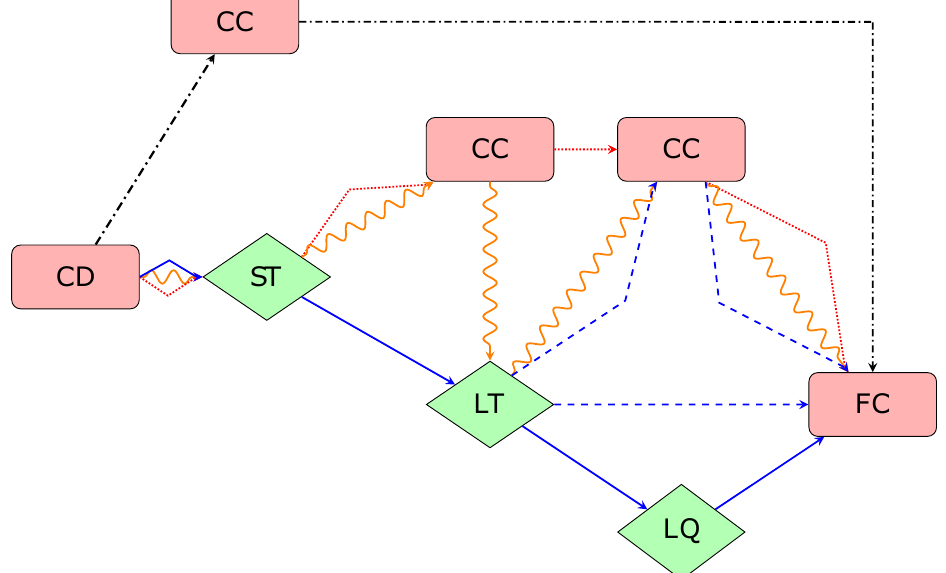
Figure 15. Flowchart of the possible sequences of phases in the entanglement evolution of R ∪ QM L . Phases in which interior reconstruction is (not) possible are in green diamonds (red rectangles). The densely dashed red (solid blue) path corresponds to the small (large) reconstruction path as illus- trated in the top (bottom) of figure 14 which we label as scenario 1 (2). The dashed blue paths correspond to limiting behaviours which require a lot of fine tuning and provide a similar large reconstruction as the blue path. The wavy orange path corresponds to one in which interior recon- struction is temporarily interrupted as shown in the middle of figure 14 corresponding to scenario